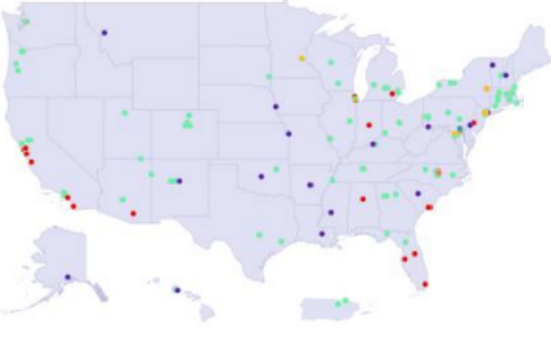
Figure 1 . Map showing 71 cohorts across US that together form the ECHO Program (Harvard Medical School.